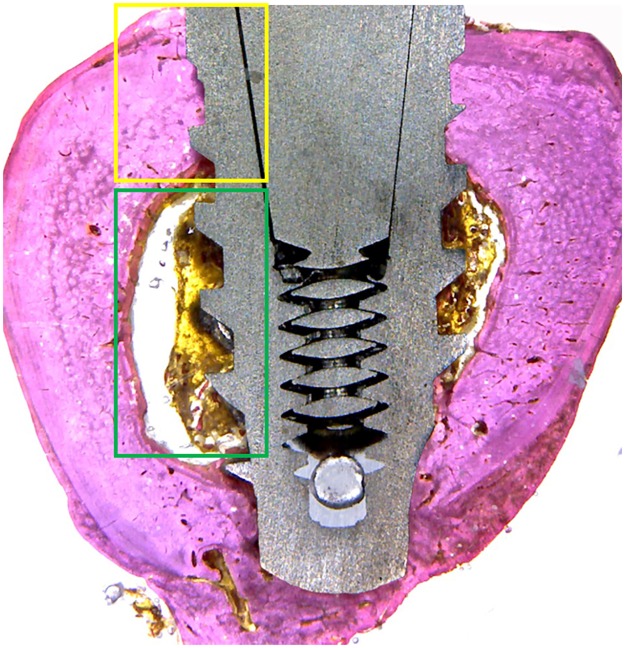
Schematic image to demonstrate the areas analyzed separately in the descriptive histologic analysis: The cortical portion corresponding to the yellow square and the medullar portion corresponding to the green square.